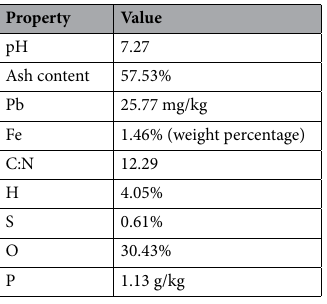
Table 2. Physicochemical properties of the goat manure.